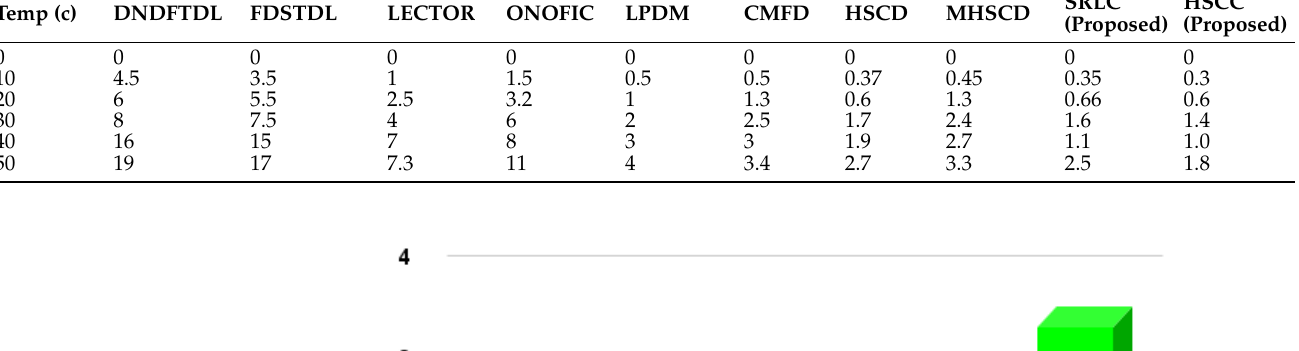
Table 5. Comparison of power dissipation of various proposed FinFET domino logic styles with existing one at 7 nm technology node for the rise of the temperature value.